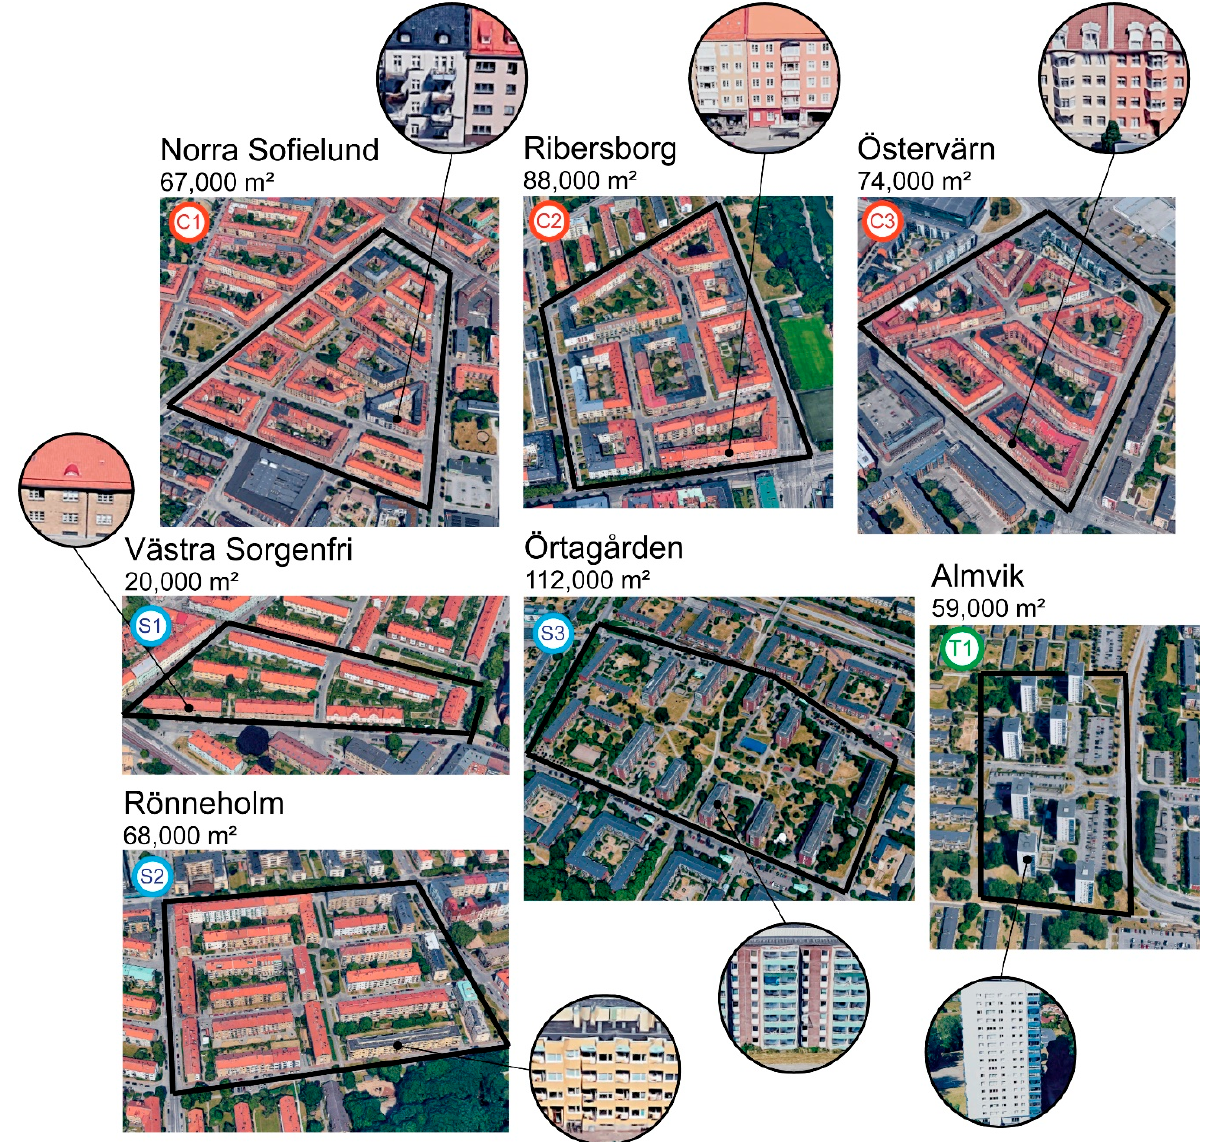
Figure 6. Malmö neighbourhood case studies used in analysis. Case study codes link to markings in the map in Figure 5. Imagery ©2022 Google, Imagery ©2022 Lantmäteriet/Metria, Maxar Technologies, Map data ©2022.